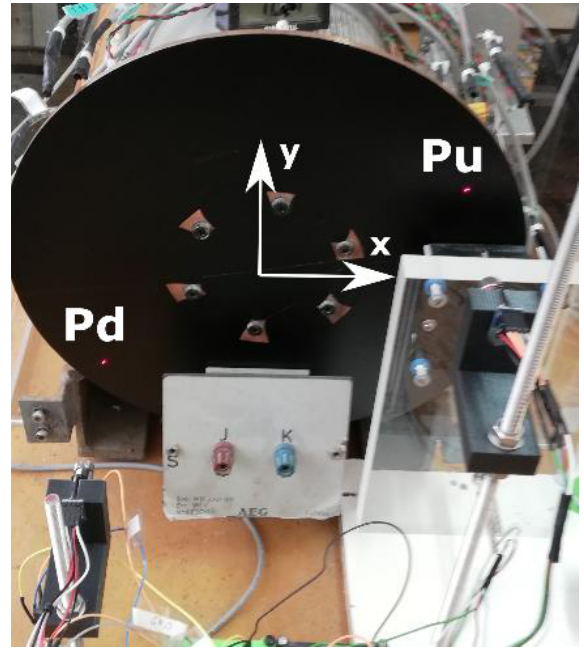
Figure 17. Perimeter measurement of the temperature simultaneously at two points, Pu and Pd, with two infrared thermometers MLX90614.